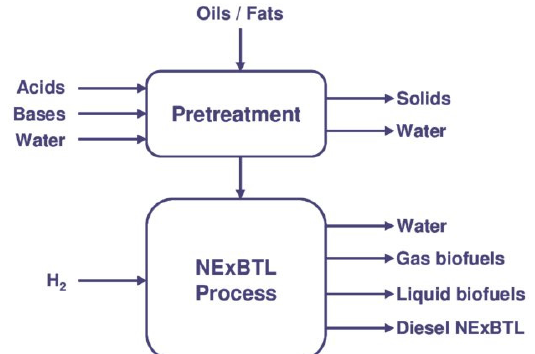
Figure 2. NExBTL catalytic hydrotreating of oils/fats technology for biodiesel production (Neste ® 2021) [132] .